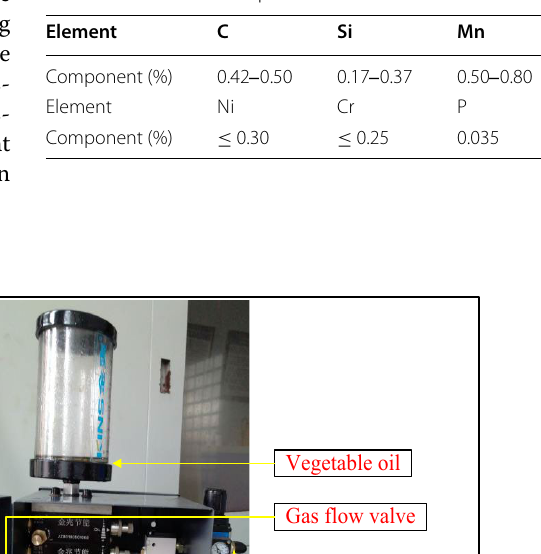
Table 1 Chemical composition of Grade 45